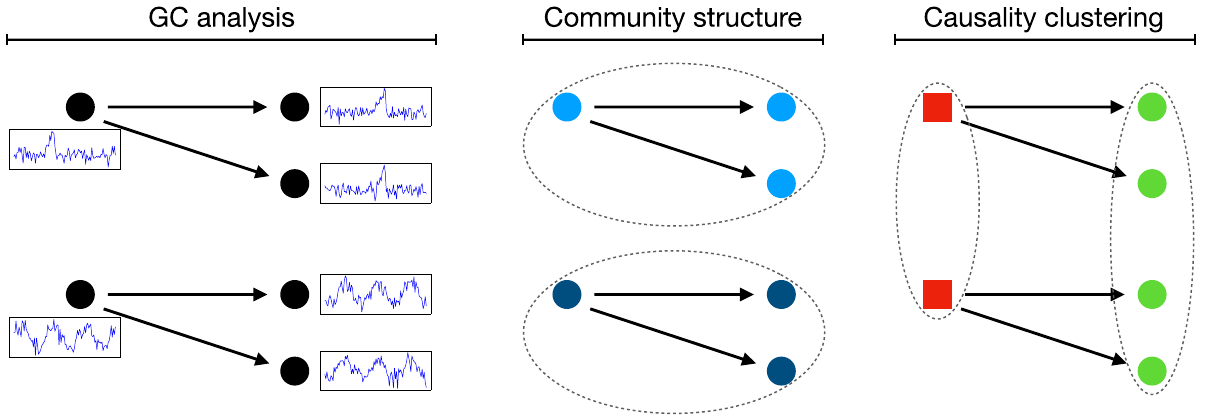
Figure 1. Causality clustering vs. network community structure. (Left) Toy system composed of six elements, with arrows representing the Granger causality relationships between them. (Center) Assignation of the elements to communities, following network theory’s definition. (Right) Assignation of the elements to two clusters, as proposed in this work.